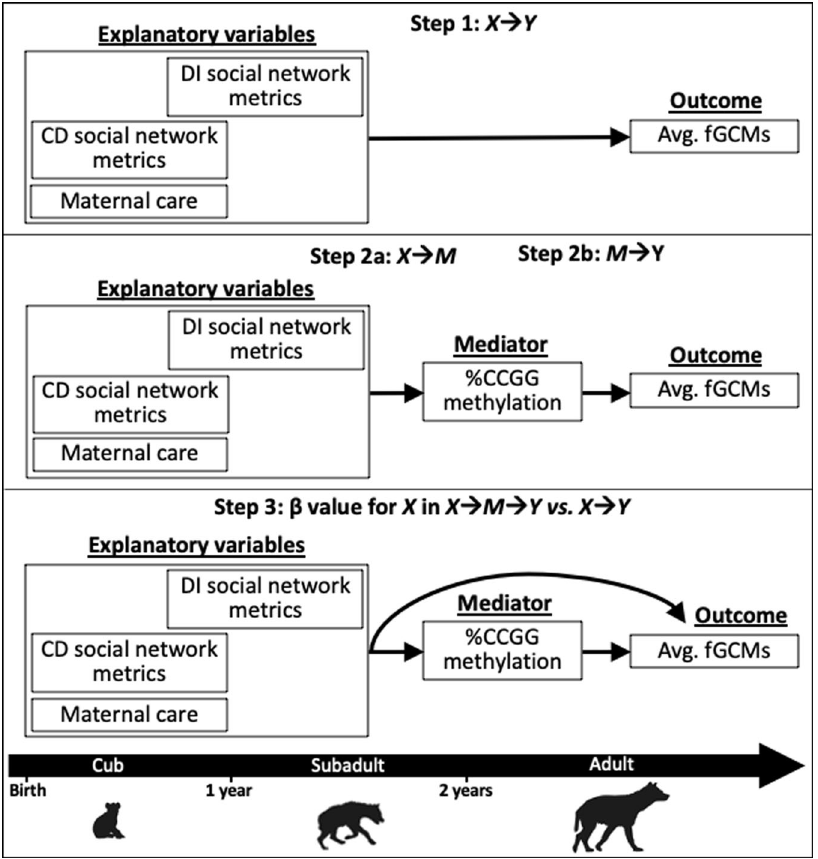
Fig. 7 A conceptual diagram outlining the analytical strategy for the three-step mediation analysis. X represents the explanatory variables of interest, M represents the potential mediator variable, and Y represents the outcome outcomes and a random intercept for hyena ID was included to output the best linear unbiased predictors (BLUPs) from this model (see Supplementary Material). These BLUPs represent the deviation of each individual ’ s average fGCMs concentration (i.e., the mean across all available measurements) from the population average. We then analyzed associations of the BLUPs with genome-wide DNA methylation using binomial regression models in MACAU 100 . In these models, the BLUPs were the explanatory variable and DNA methylation of each sequenced CpG site (count of methylated divided by total CpG sites) was the outcome (Supplementary Fig. 7a). We controlled for offspring age in months at the time of darting as a precision covariate, and we accounted for genetic correlations by including a relatedness covariance matrix based